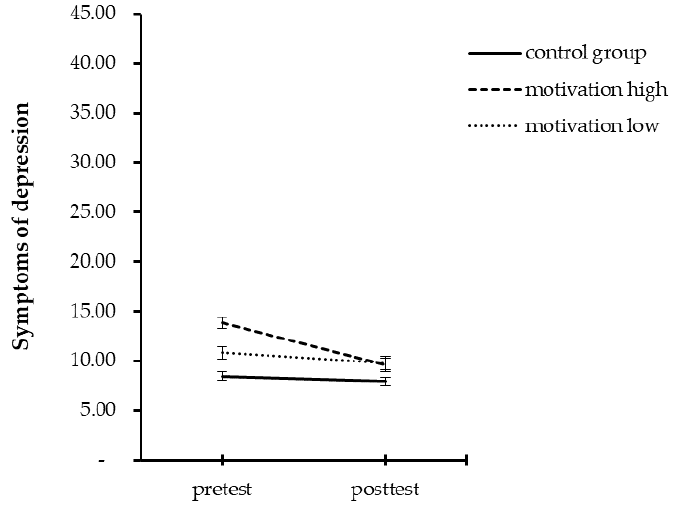
Figure 3. Mean summary for pre- and post-test scores for symptoms of depression separated by groups.